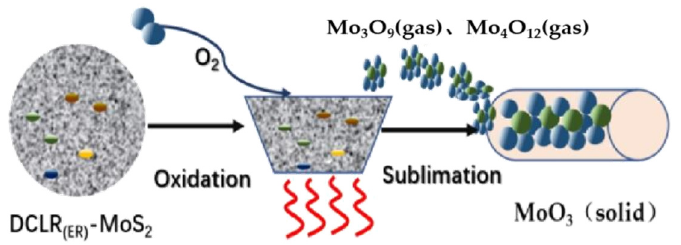
Figure 8. The illustration of high-temperature reaction process of DCLR (ER) -MoS 2 system